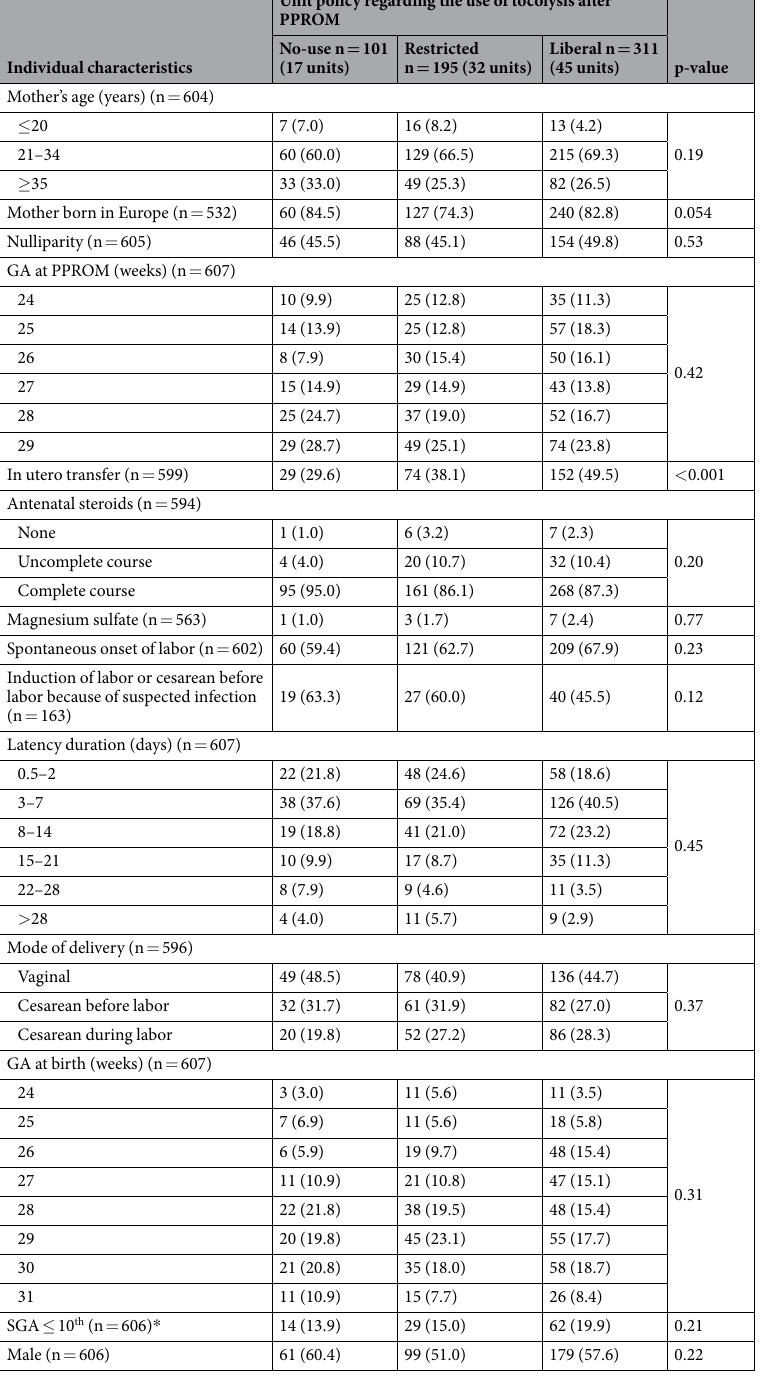
Table 2. Association of individual characteristics and unit policy of tocolysis after PPROM. GA: gestational age, PPROM: preterm premature rupture of membranes, SGA: small for gestational age * According to intrauterine growth curves, based on weight in each country collected in the Euro-Peristat project and modeled using Gardosi’s